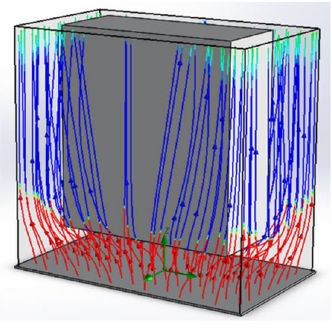
Figure 5. Velocity profile of the flue gas.